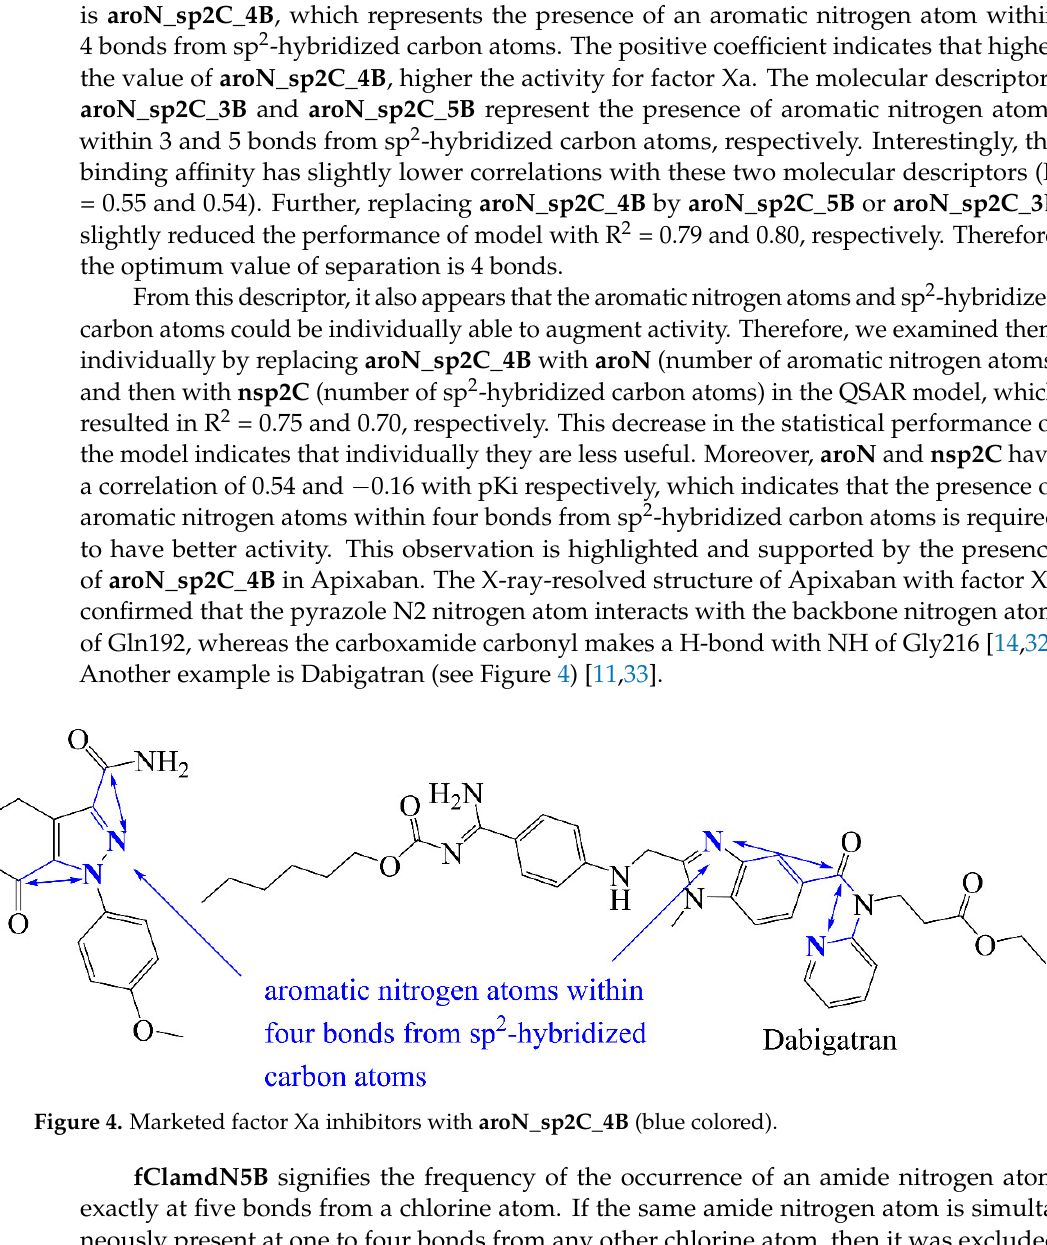
Figure 5. Representative examples molecule A and B to understand fClamdN5B (highlighted by red colored bonds and atoms) . The molecular descriptor fsp2Osp3O6B stands for the frequency of occurrence of sp 3 -hybridized oxygen atoms exactly at six bonds from sp 2 -hybridized oxygen atoms. If the same sp 3 -hybridized oxygen atom is also present at five or less bonds from any other sp 2 -hybridized oxygen atom, then it was omitted during the calculation of fsp2Osp3O6B . Replacement of this molecular descriptor with a similar molecular descriptor sp3O_sp2O_6B , which represents the total number of sp 3 -hybridized oxygen atoms within 6 bonds from sp 2 -hybridized oxygen atoms, led to a visible decrease in the statisti- cal performance of the model (R 2 = 0.76). Therefore, the idea to exclude the same sp 3 -hy- bridized oxygen atom which is simultaneously present at five or less bonds from any other sp 2 -hybridized oxygen atom provided useful and additional understanding of concealed structural features. The negative coefficient for fsp2Osp3O6B in the QSAR model indicates that increas- ing the value of this descriptor could lead to poor anti-thrombotic activity. In addition, it has a negative correlation of 0.43 with the activity. From 1121 molecules in the present data set, 358 molecules with a better activity (Ki = 0.007 to 10 nM) do not possess such a combination, whereas only 131 molecule,s have such a combination with their Ki ranging